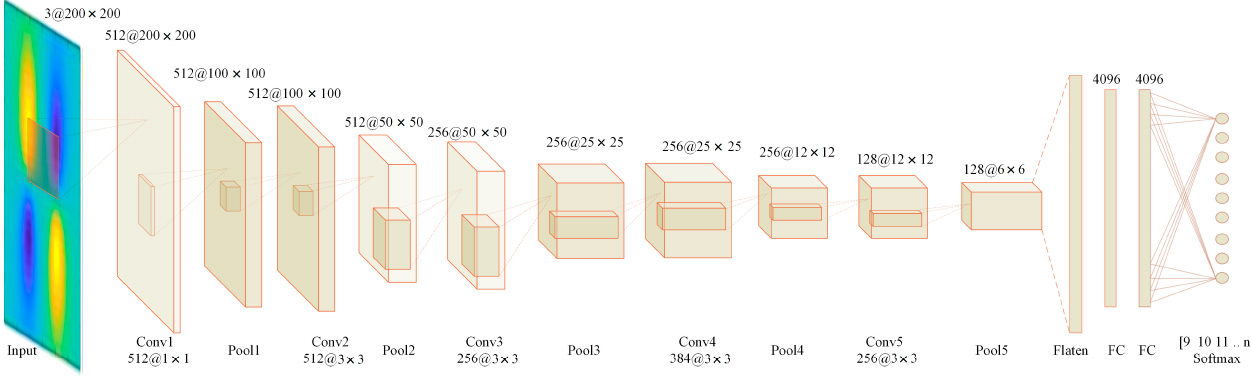
Figure 2. Optimized AlexNet network